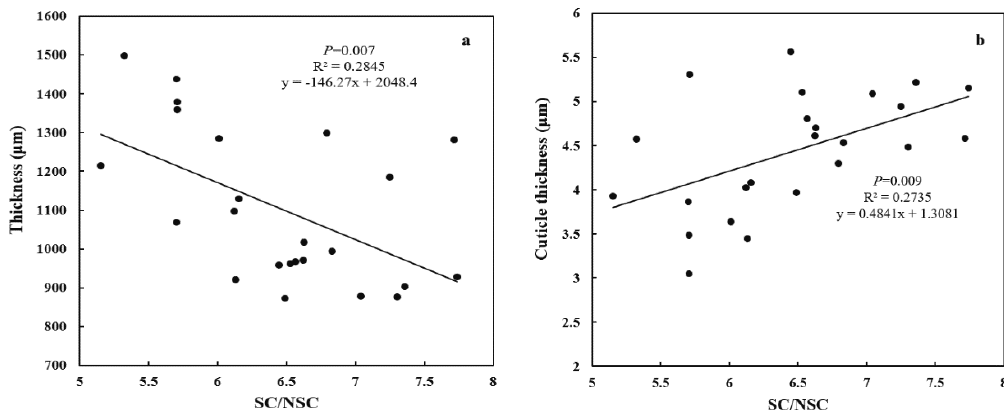
Figure 5. Variations in leaf anatomy for P. thunbergii along the coast-inland gradient. ( a ) Epidermal thickness, and ( b) Cuticle thickness.